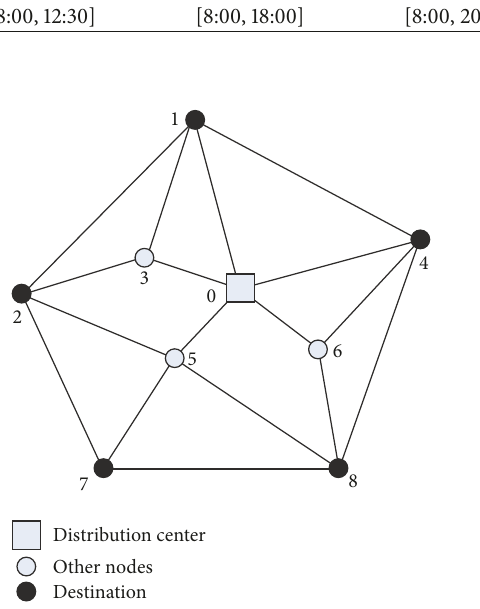
Figure 5: A test network for transportation of hazardous